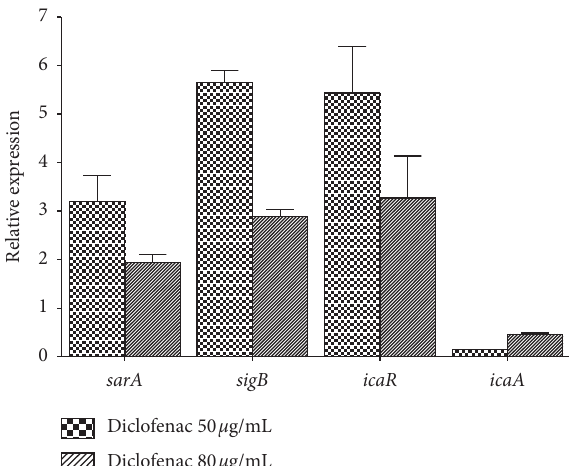
Figure 3: Relative expression of sarA , sigB , icaA, and icaR genes in a S. aureus strain. The SA139 strain was grown to the exponential phase and then treated with diclofenac (50 and 80 μ g/mL). Medium without diclofenac was used as the control. The gyrB gene was used as an endogenous reaction control. Each bar represents the mean of relative expression with range for biological